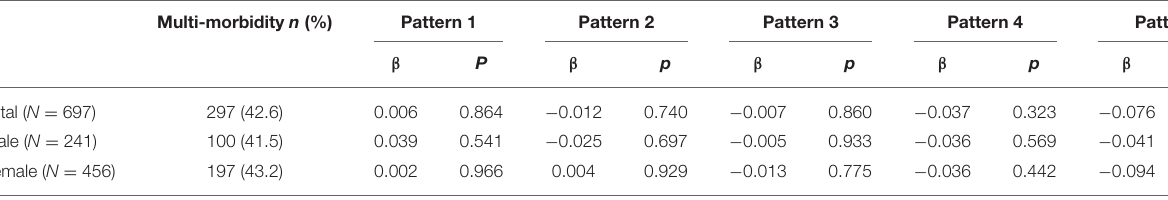
TABLE 8 | Association of prevalence of multimorbidity and dietary patterns across sex categories. Multi-morbidity n (%)